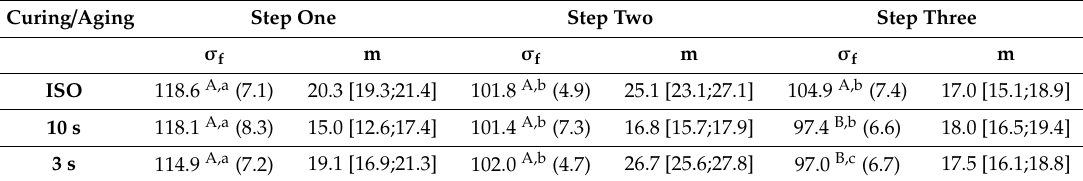
Table 1. Three-point bending test: flexural strength σ f in MPa (mean and standard deviation) and Weibull modulus m with 95% confidence interval. Superscript letters indicate homogeneous groups; Capital letters indicate sub-groups related to columns; Lowercase letters indicate sub-groups related to rows; Tukey’s post-hoc test ( α = 0.05).